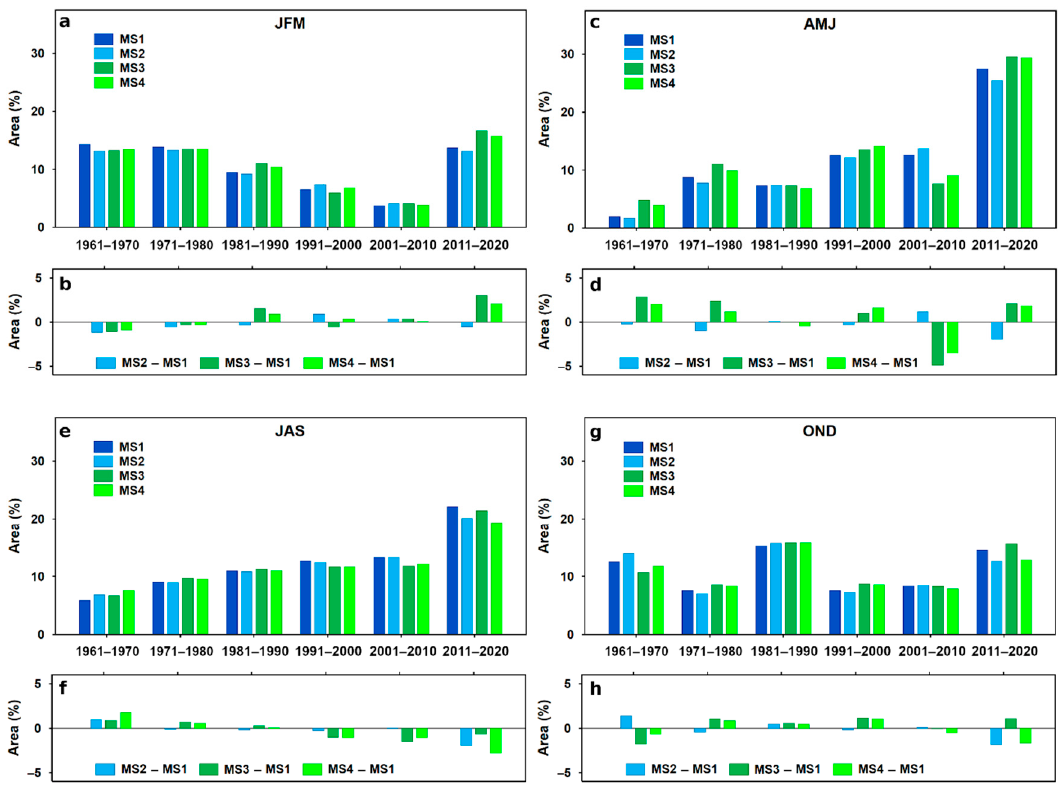
Figure 4. Decadal means of areas with 10th ‐ percentile soil drought (% of grid points) ( a ), ( c ), ( e ), and ( g ) for four SoilClim model setups (MS1–MS4) and differences between MS2–4 and MS1 ( b ), ( d ), ( f ), ( h ) in the 0–100 cm soil layer in the Czech Republic in JFM, AMJ, JAS, and OND in the 1961–2020 period.